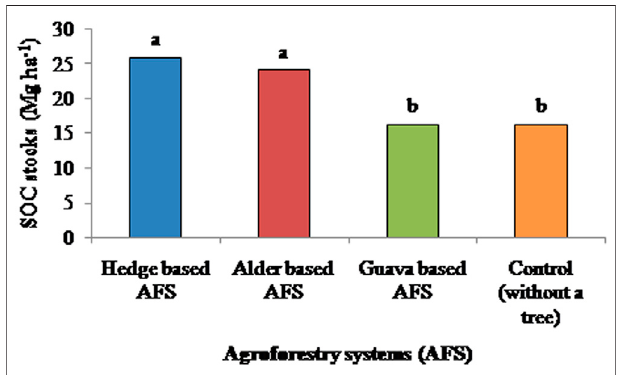
FIGURE 4 | Effects of various agroforestry systems on soil organic carbon stocks (SOC stocks) in the soil depth of 0 – 30 cm of the Indian sub- Himalayas. (Means of different land use systems within a column followed by similar lowercase letters are not signi fi cant at p < 0.05 based on Tukey ’ s HSD test.)